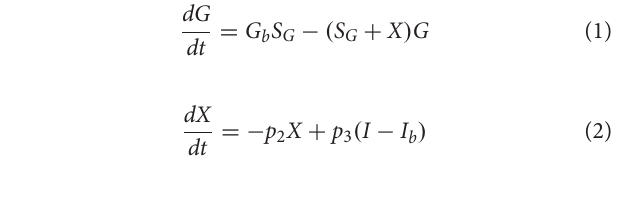
TABLE 1 | Parameters varied to make each figure. The parameter shown in column is the initial value of σ . Figure, case